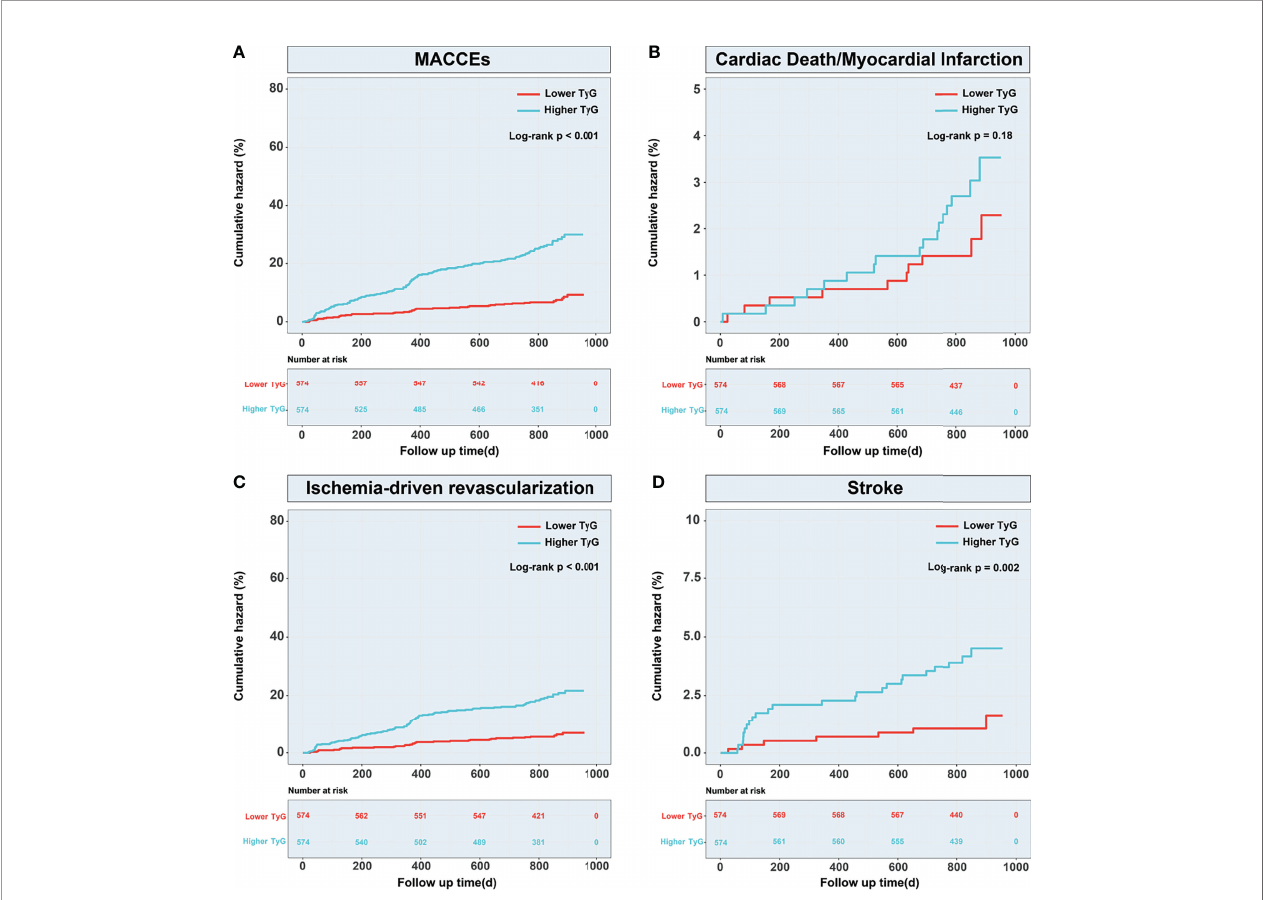
FIGURE 6 | Kaplan – Meier curves for MACCEs and endpoint events according to the propensity score-matched population. (A) Kaplan – Meier curves for MACCEs; (B) Kaplan – Meier curves for cardiac death or non-fatal myocardial infarction; (C) Kaplan – Meier curves for ischemia-driven revascularization; (D) Kaplan-Meier curves for stroke. TyG, triglyceride-glucose; MACCEs, major adverse cardiovascular and cerebrovascular events.